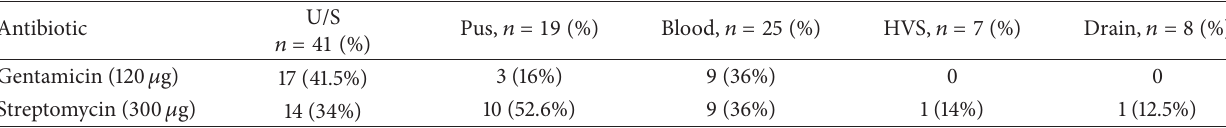
Table 2: Prevalence of High level resistance in Enterococcus spp.